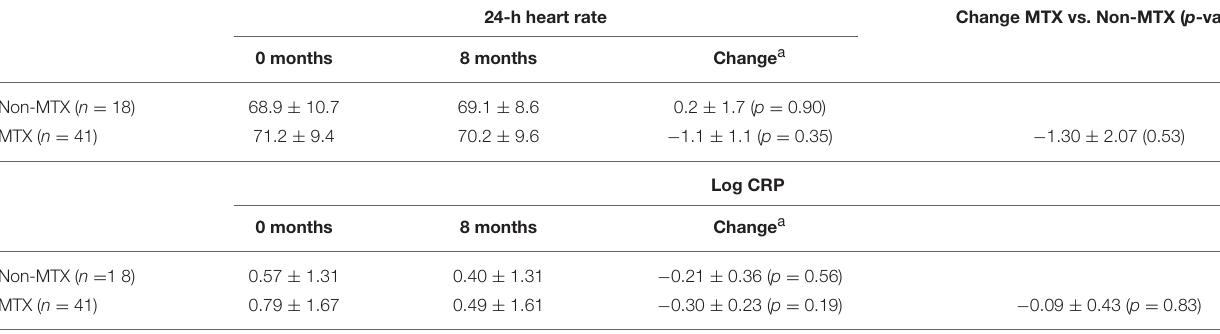
TABLE 4 | Twenty-four hour heart rate and CRP values at baseline and follow-up for each group and estimated